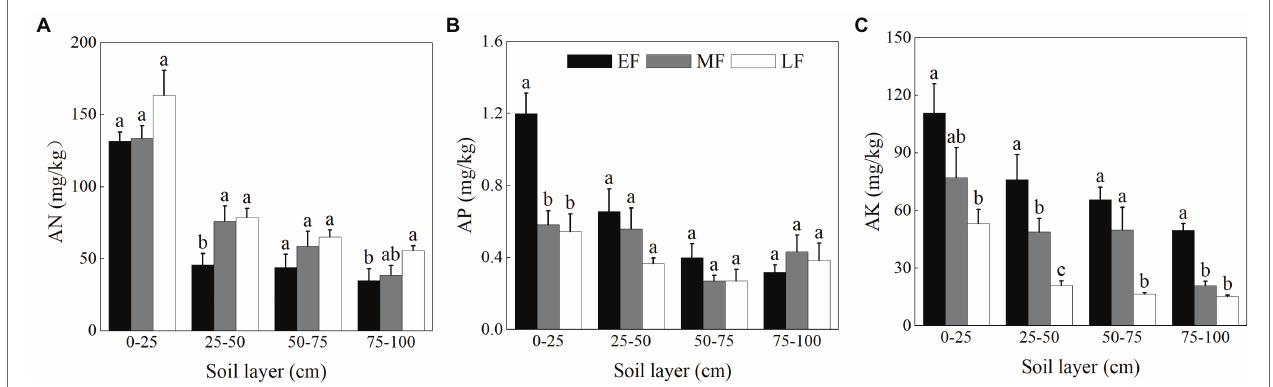
FIGURE 3 | The contents of AN (A) , AP (B) , and AK (C) in the 0–100 cm soil layer of different forests. Values are the means ± SE ( n = 6). Lowercase letters above the columns represent statistically significant differences among stand types for the same soil layer (Duncan’s tests, p < 0.05). AN, alkali-hydrolyzable nitrogen; AP,